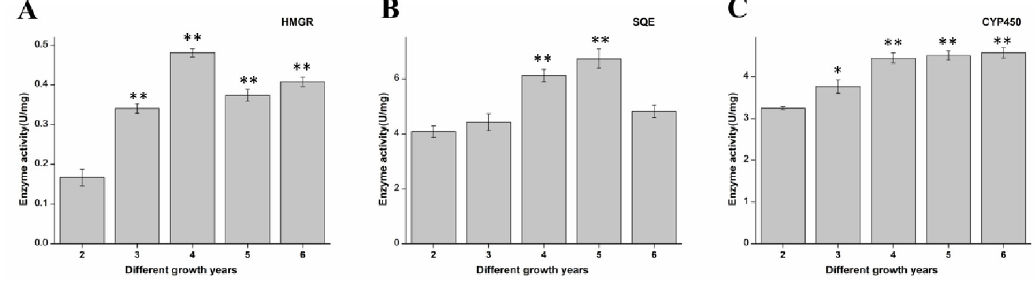
Fig 3. Enzyme activity in ginseng in different years. A: HMGR enzyme activity. B: SQE enzyme activity. C: CYP450 enzyme activity. The enzyme activity was uniformly standardized to U/ ginseng; � p < 0.05 vs 2 years, �� p < 0.01 vs 2 years.